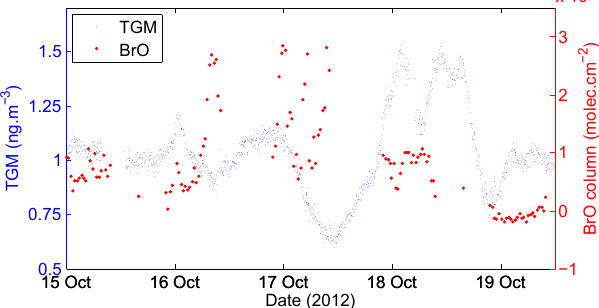
Figure B1. Total gaseous mercury (TGM) and column BrO from the MAX-DOAS instrument. The 17 October experiences signifi- cant concentrations of BrO, along with simultaneous depletion of TGM, just prior to the 18 October nucleation